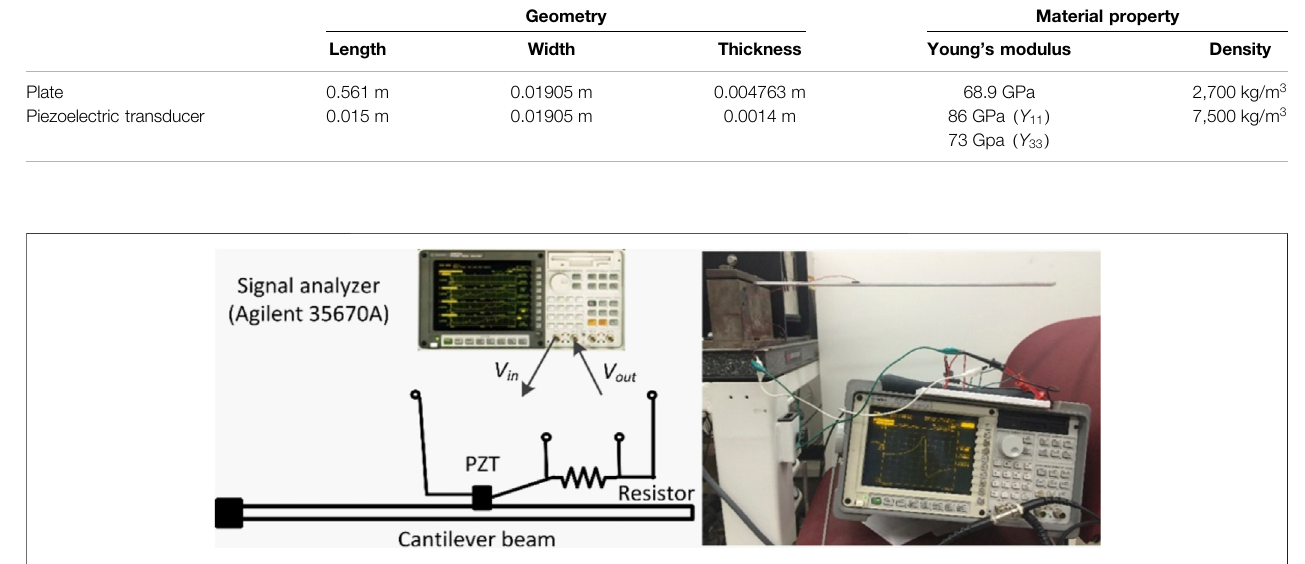
FIGURE 2 | Experimental